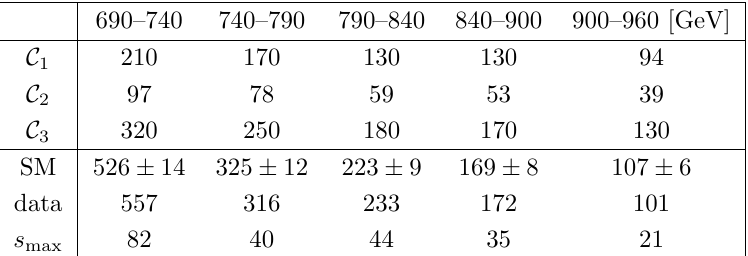
Table 4 . Coe(cid:14)cients in TeV 4 and rounded to two signi(cid:12)cant (cid:12)gures for pp ! NNg ( q ) obtained upon recasting the experimental analysis of ref. [28] for L = 35 : 9 fb (cid:0) 1